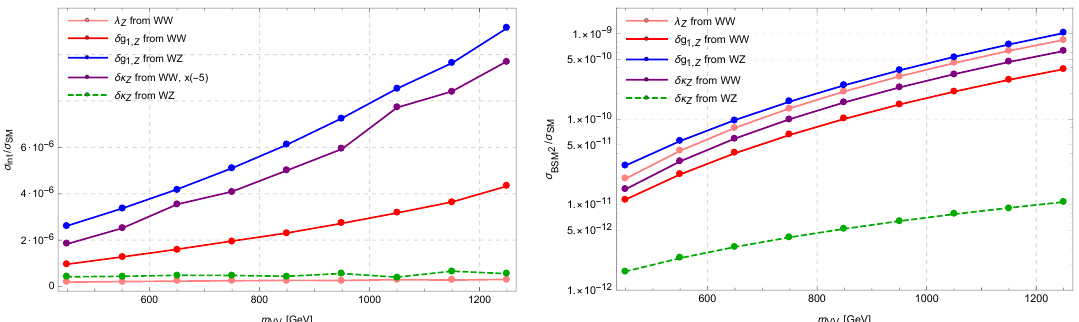
Figure 1 . Results from a MadGraph5 simulation of the pp ! V W process mediated by anomalous TGCs, see the main text. The error bars of both plots due to statistical errors is within the width of the plotted lines. We multiplied the line (cid:27) int =(cid:27) SM of (cid:14)(cid:20) Z from WW by (cid:2) ( (cid:0) 5) for illustrative